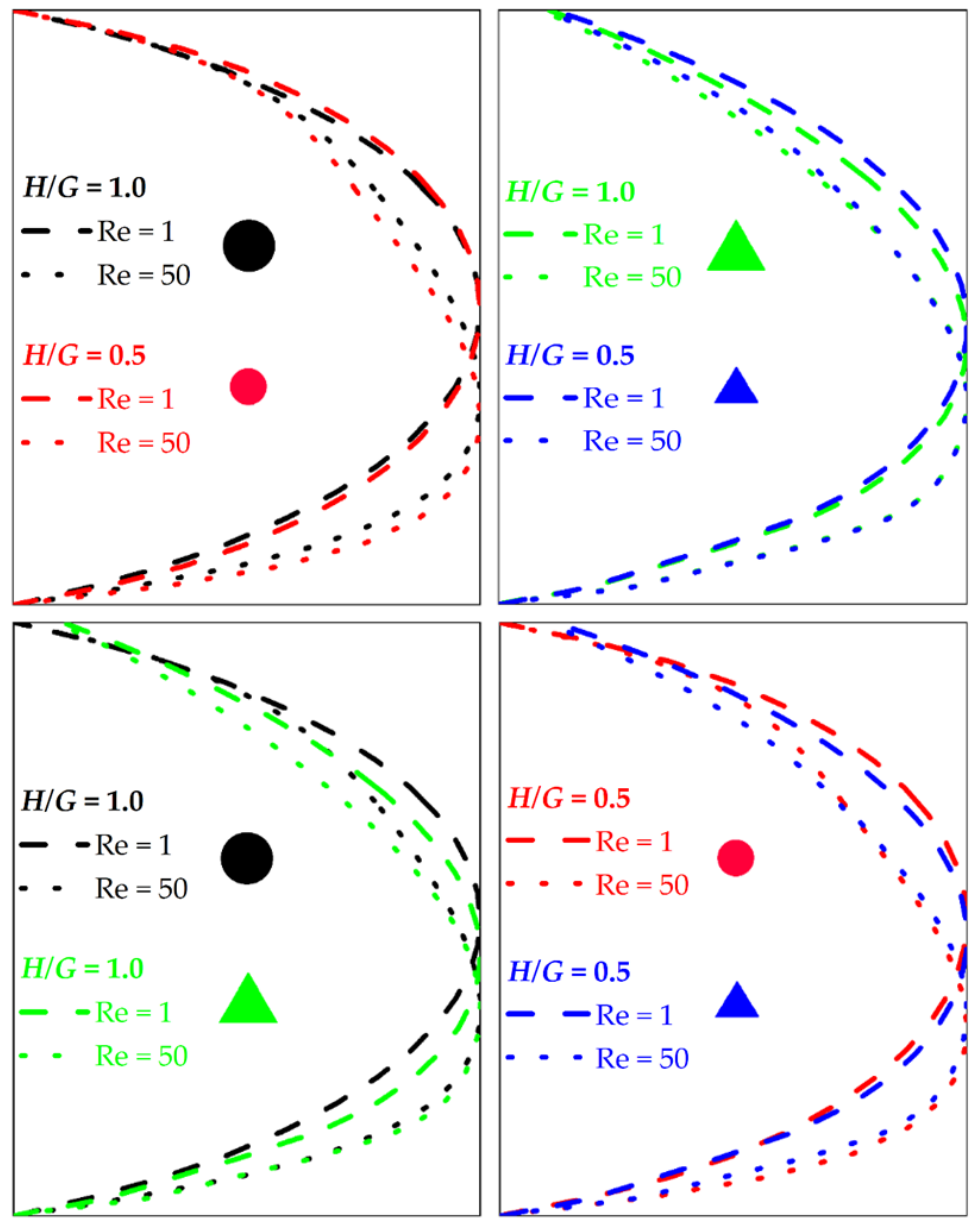
Figure 6. Mean velocity profiles between neighboring posts at Re = 1 and Re = 50 for the H / G ratios as a comparison for circular posts ( top left ) and triangular posts ( top right ), as well as a comparison between circular and triangular posts for H / G = 1 ( bottom left ) and H / G = 0.5 ( bottom right ). With circular posts, a smaller H / G leads to a more plug-like velocity profile. Triangular posts and high Reynolds numbers lead to an asymmetry of the velocity profile in the direction of the lower post.